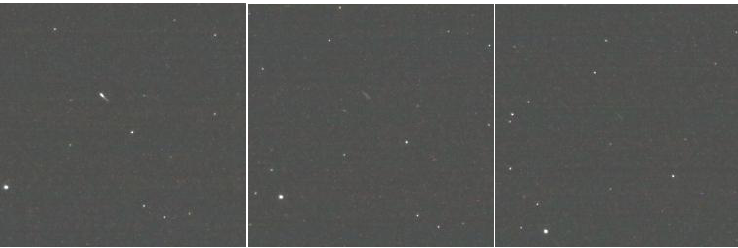
Figure 15. Variable perceived brightness of Molniya 1-91 due to rapid spinning. From saturation (left) to a brightness of 36 DNU (middle) and then to 12 DNU